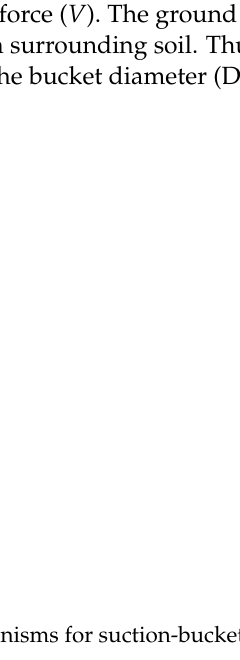
Figure 6. Simplified loading mechanisms for suction-bucket-supported OWT.